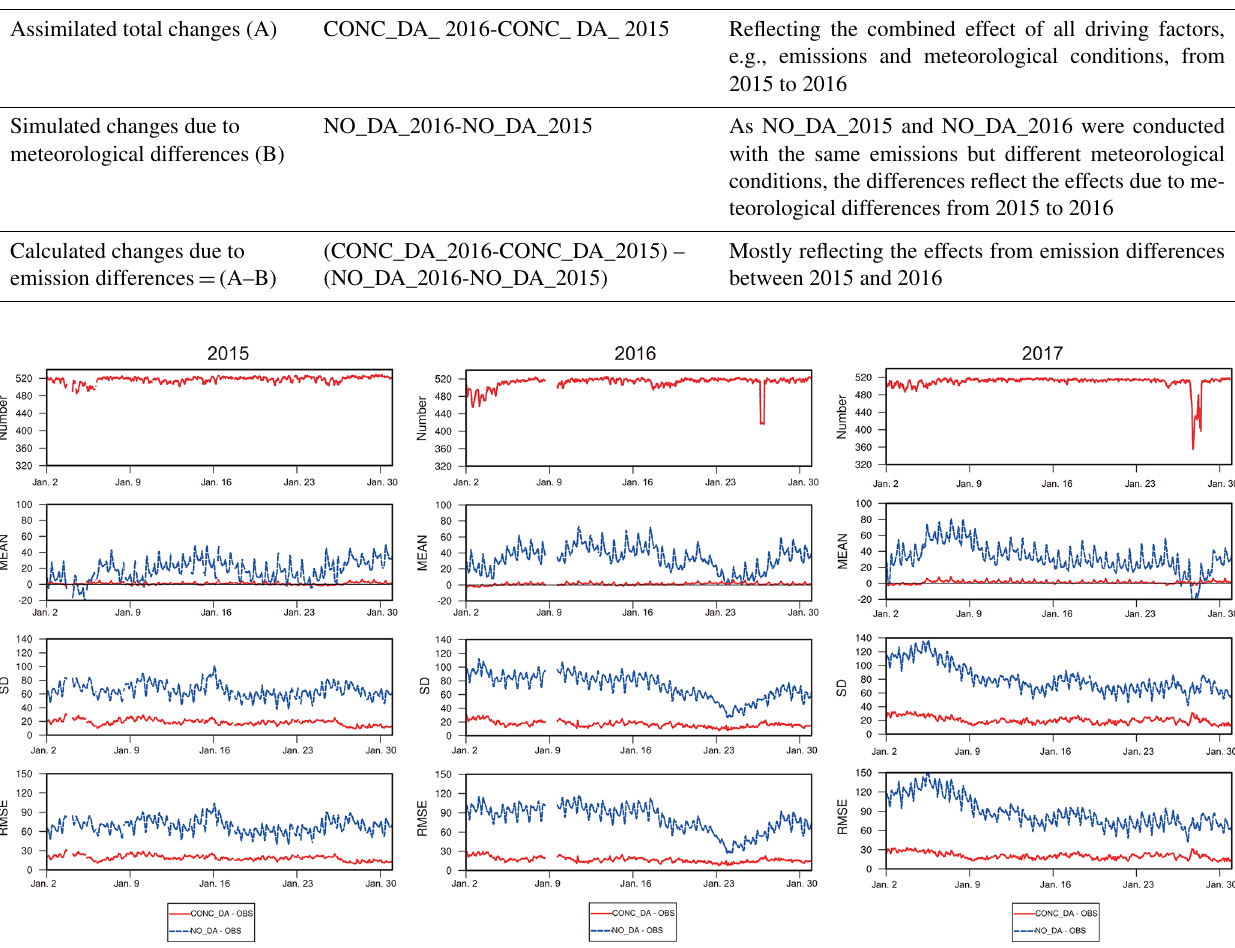
Table 2. The approach used to distinguish the different impacts of meteorological conditions and emissions by calculating them from different scenarios (taking 2015 and 2016 as an example).